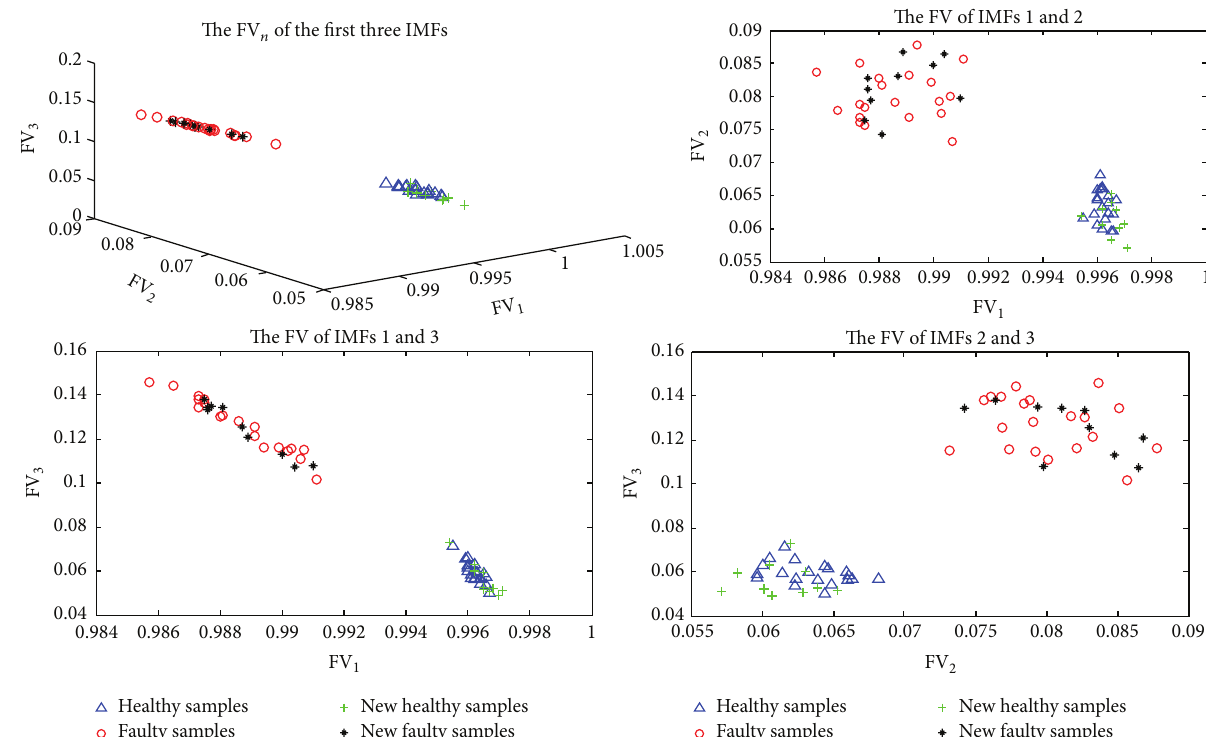
Figure 7: The normalized energy of the three first IMFs (FV 𝑛 ) with new samples, SNR = 10 (speed = 200 Hz and load = 1.0kN).